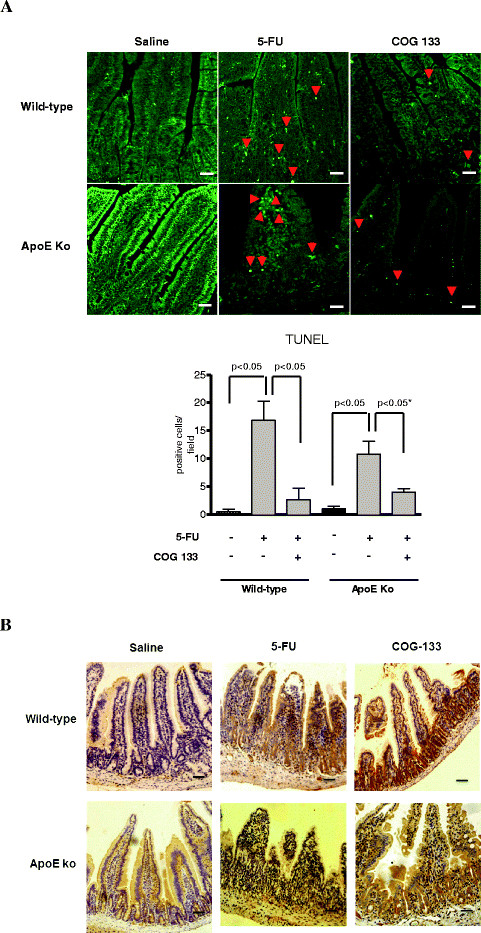
A. Terminal deoxynucleotidyl transferase-mediated dUTP nick end-labeling (TUNEL) analysis of apoptosis in C57BL6J apoE knock-out and wild-type mice challenged by 5-FU-induced intestinal mucositis (450 mg/kg via i.p., single dose) and treated with the apoE mimetic peptide COG 133 (3 μM, via i.p., 12/12 h, vol. 10 μl/g) or 0.9% saline (i.p.). Values represent mean ± SEM and were analyzed by one-way ANOVA and Bonferroni.. TUNEL-labeled cells (head arrows) were found increased 5-FU treated mice. Effect that was reversed by ApoE COG 133 peptide. Scale bars = 10 μm. B. NF-κB p50 representative immunohistochemistry of the proximal intestine tissue (X400) after four days of 5-FU-challenge. Note higher NF-κB immunlabeling in recovered crypts treated by ApoE COG 133 peptide. Scale bars, 10 μm.